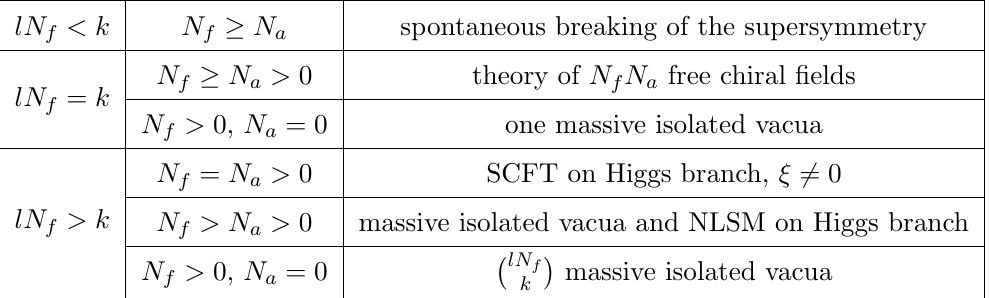
Table 1 . Phase structure of N = (2 ; 2) U( k ) gauge theory with N f fundamental, N a